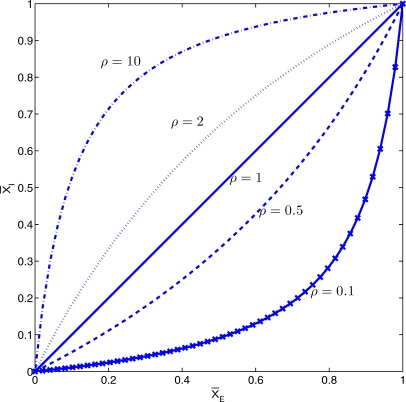
Fixed Point Loci When the Activities are ProportionalGeometrical loci of the averaged system's fixed points when the excitatory and inhibitory activity function are proportional to each other, as described in Equation 8. The locus depends on the parameter ratio ρ. When ρ < 1 fixed points are located in the lower half of the plane (
) and vice versa. We can infer from the assumptions in Equations 5 and 6 that as fixed points approach the lower-right corner of the phase plane, activity increases. Thus, decreasing ρ changes the overall behavior from a depressing to a facilitating one.